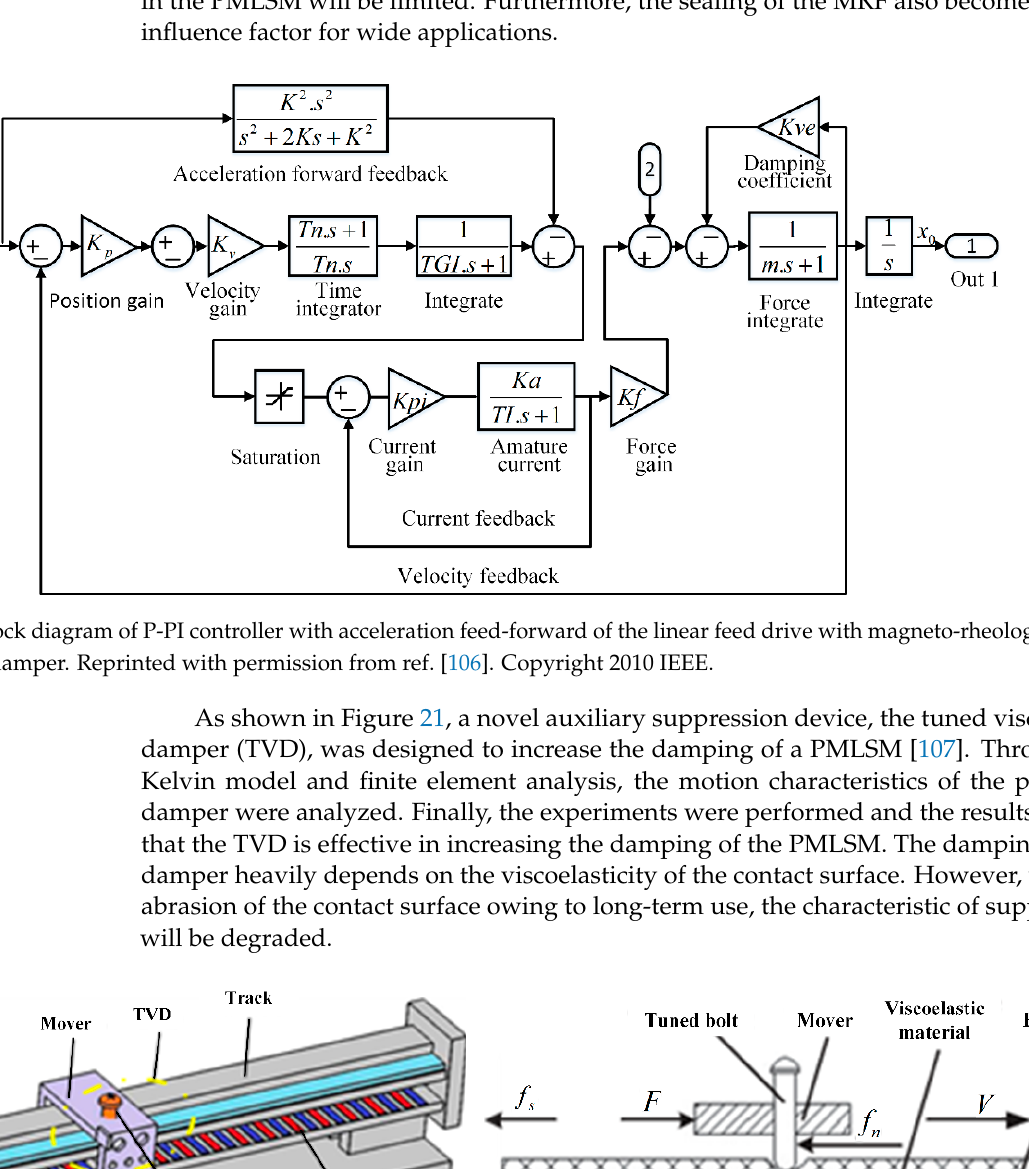
16 of 28 Figure 19. Neural network learning adaptive robust controller framework. Reprinted with permis- sion from ref. [4]. Copyright 2017 IEEE. As mentioned above, feed-forward control considering the normal dynamic model can improve the dynamic performance. In terms of repetitive motion, a feed-forward con- troller with self-learning, such as iterative learning, fuzzy control, reinforcement learning, neural networks, etc., can obtain an excellent performance in terms of transient response and even approximately error-free trajectory tracking. 4.3. Damper